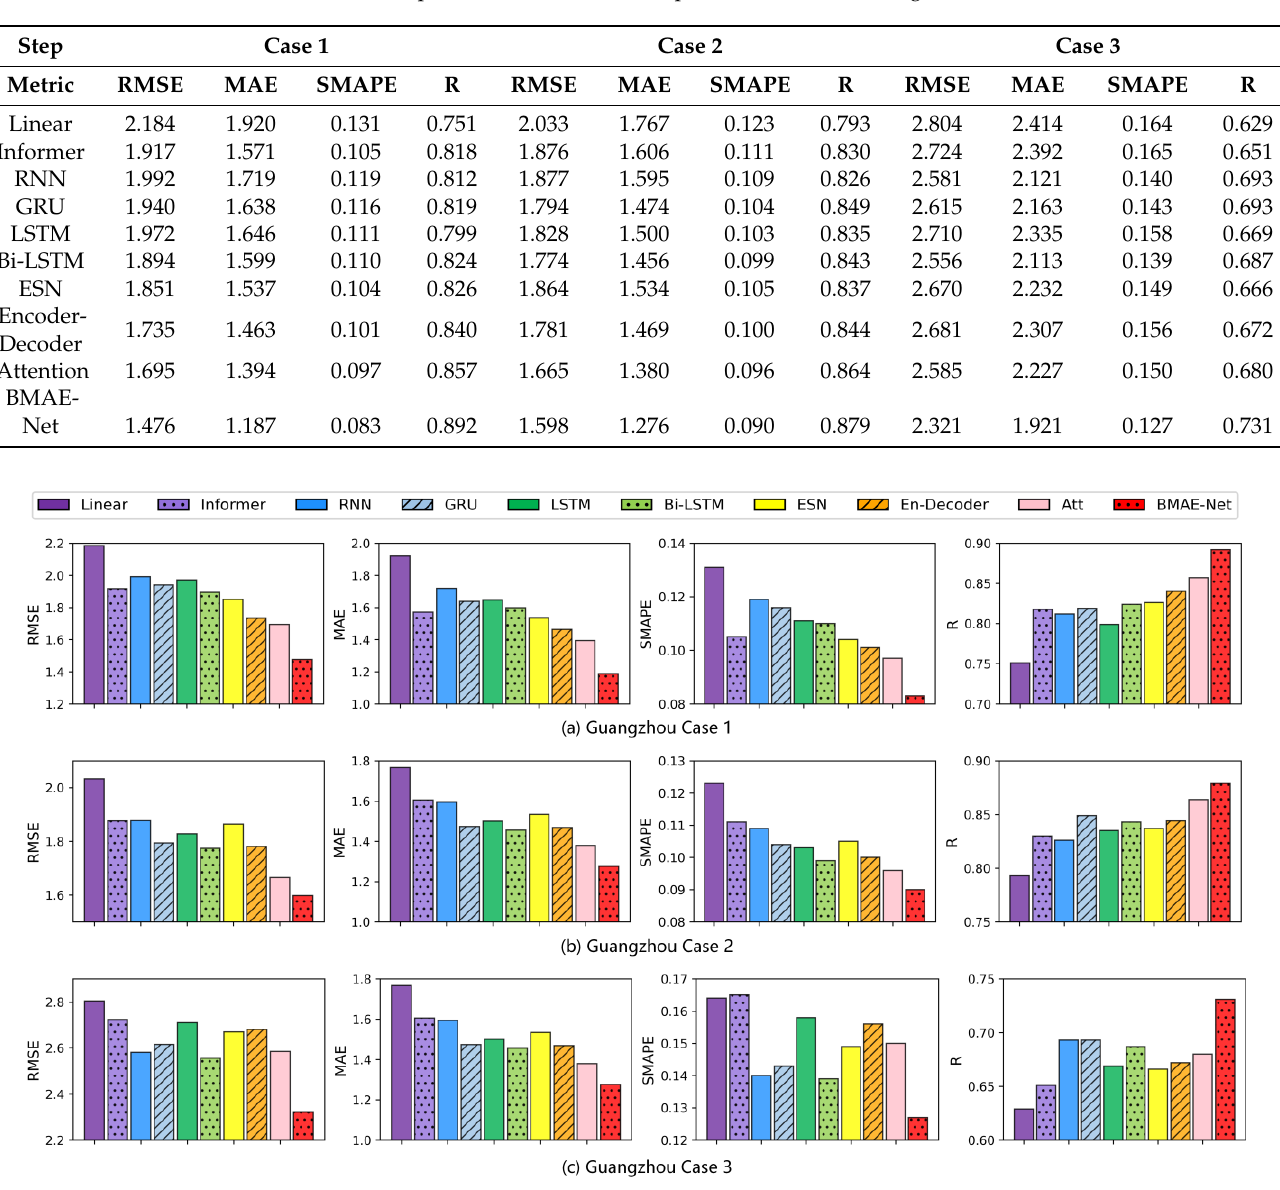
Table 5. Experimental results for temperature from the Guangzhou station.